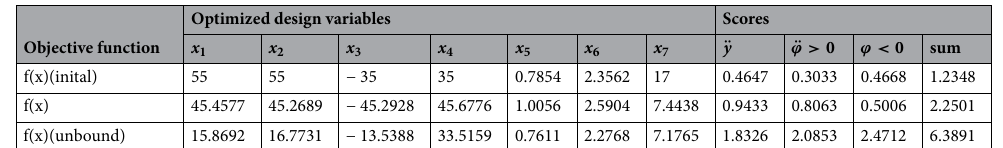
Table 5. Optimal design variables whose objective function is scored by the normalization from other optimums. Above is the normalized score for the initial design. All three performance was improved compared to the original model. Below is the optimized design variables optimized without x 1 , x 2 limits. All objective function is normalized by the bounded optimal design parameters, therefore the sum of the score is possible to be above 3.